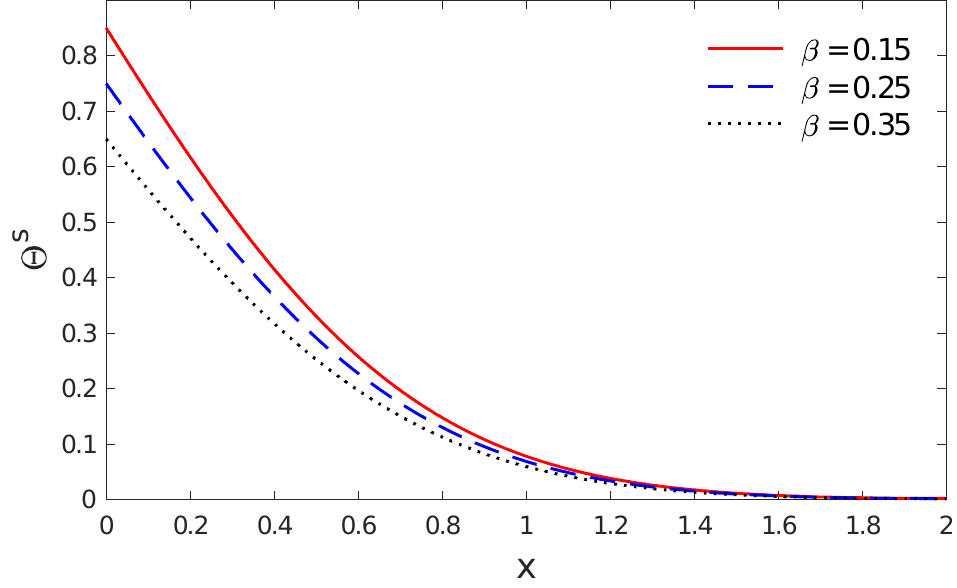
Figure 2. The variation of solid temperature Θ 𝑠 versus 𝑥 for several values of porosity.